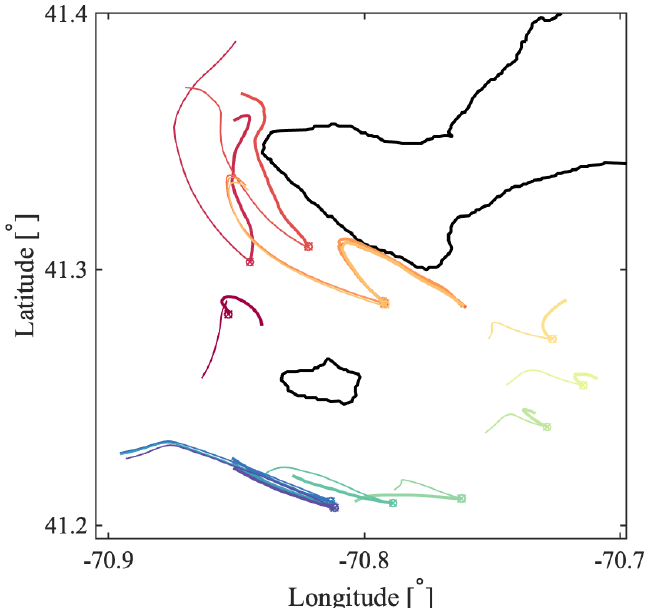
Figure A10. Comparison between real and simulated drifter trajectories for the 2017 No Man’s Land experiment. The trajectories of CODE drifters are plotted with thick lines. The corresponding numerical trajectories, simulated with the same initial conditions as their corresponding CODE drifter, are plotted with thin lines.